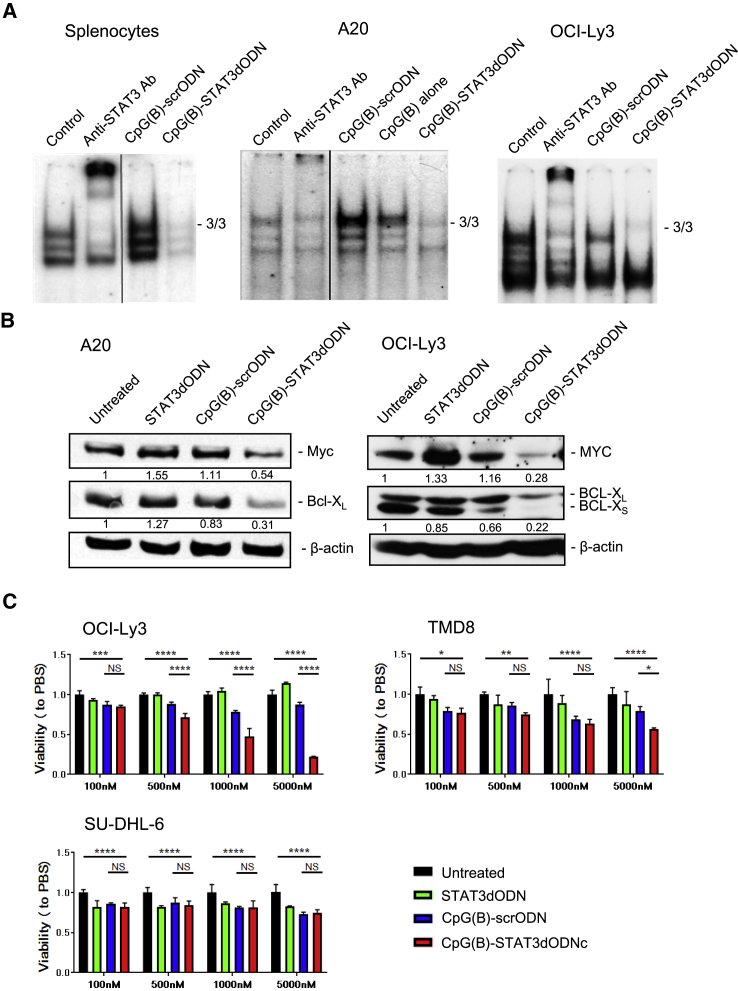
CpG(B)-STAT3dODN Reduces STAT3 DNA Binding and Downstream Target Gene Expression In Vitro(A) Mouse splenocytes, A20 cells, or human OCI-Ly3 cells were incubated for 48 hr with CpG(B)-STAT3dODN, CpG(B)-scrODN, or CpG(B) alone (500 nM). Next, cells were lysed, and the nuclease extracts were incubated with radioactive hSIE DNA probe specific to STAT3. STAT3-specific antibodies were used to confirm band identity (supershift): S3/S3 indicates position of STAT3 homodimers. (B) A20 and OCI-Ly3 cells were incubated for 72 hr in the presence of 500 nM CpG(B)-STAT3dODN, negative control CpG(B)-scrODN, or STAT3dODN alone. The expression level of c-MYC and BCL-XL was assessed in cell lysates using western blotting. Protein band intensities were quantified densitometrically using ImageJ v.1.46 and normalized to levels of β-actin as indicated; shown are the results from one of three independent experiments with similar outcomes. (C) Dose-dependent cytotoxic effect of CpG-STAT3dODN on STAT3-dependent human ABC-DLBCL cells. 105 human DLBCL cells (ABC-DLBCL: OCI-Ly3, TMD8; GC-DLBCL: SU-DHL6) per well were seeded in 96-well plate in IMDM/1% FBS medium. Cells were treated with CpG(B)-STAT3dODN or control oligonucleotides at concentrations as indicated for 3 days. The cell viability was detected using Vita-Orange Cell Viability Reagent (Biotool). STAT3-independent SU-DHL6 cells were used as a negative control. Shown are the results from one of two independent experiments performed in triplicates. Data indicate means ± SEM. *p < 0.05; **p < 0.01; ***p < 0.001, ****p ≤ 0.0001; NS, not significant.